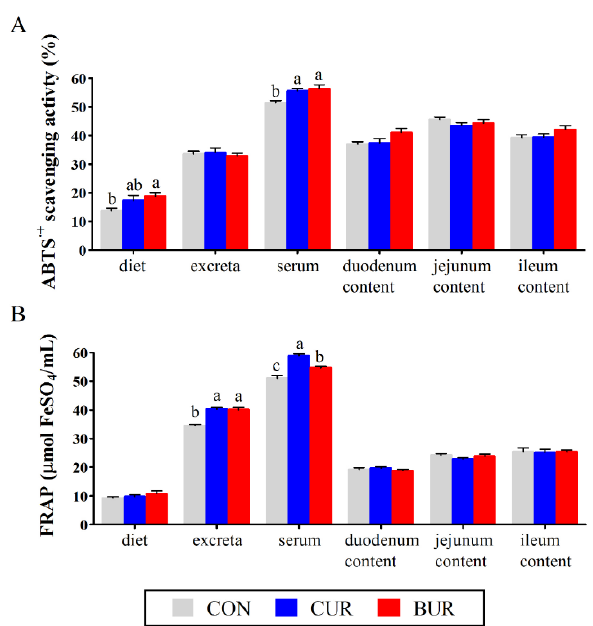
Figure 3. E ff ects of curcumin and bisdemethoxycurcumin on the antioxidant capacity of diets, excreta, serum, and small intestinal content (duodenum, jejunum and ileum) while using the ( A ) ABTS and ( B ) FRAP methods in broiler chickens (Experiment 2). Results are expressed as the mean ± SEM. Columns labeled with di ff erent letters are significantly di ff erent ( p < 0.05). CON group, birds were fed the basal diet; CUR group, birds were fed the basal diet with 150 mg / kg curcumin; BUR group, birds were fed the basal diet with 150 mg / kg bisdemethoxycurcumin.